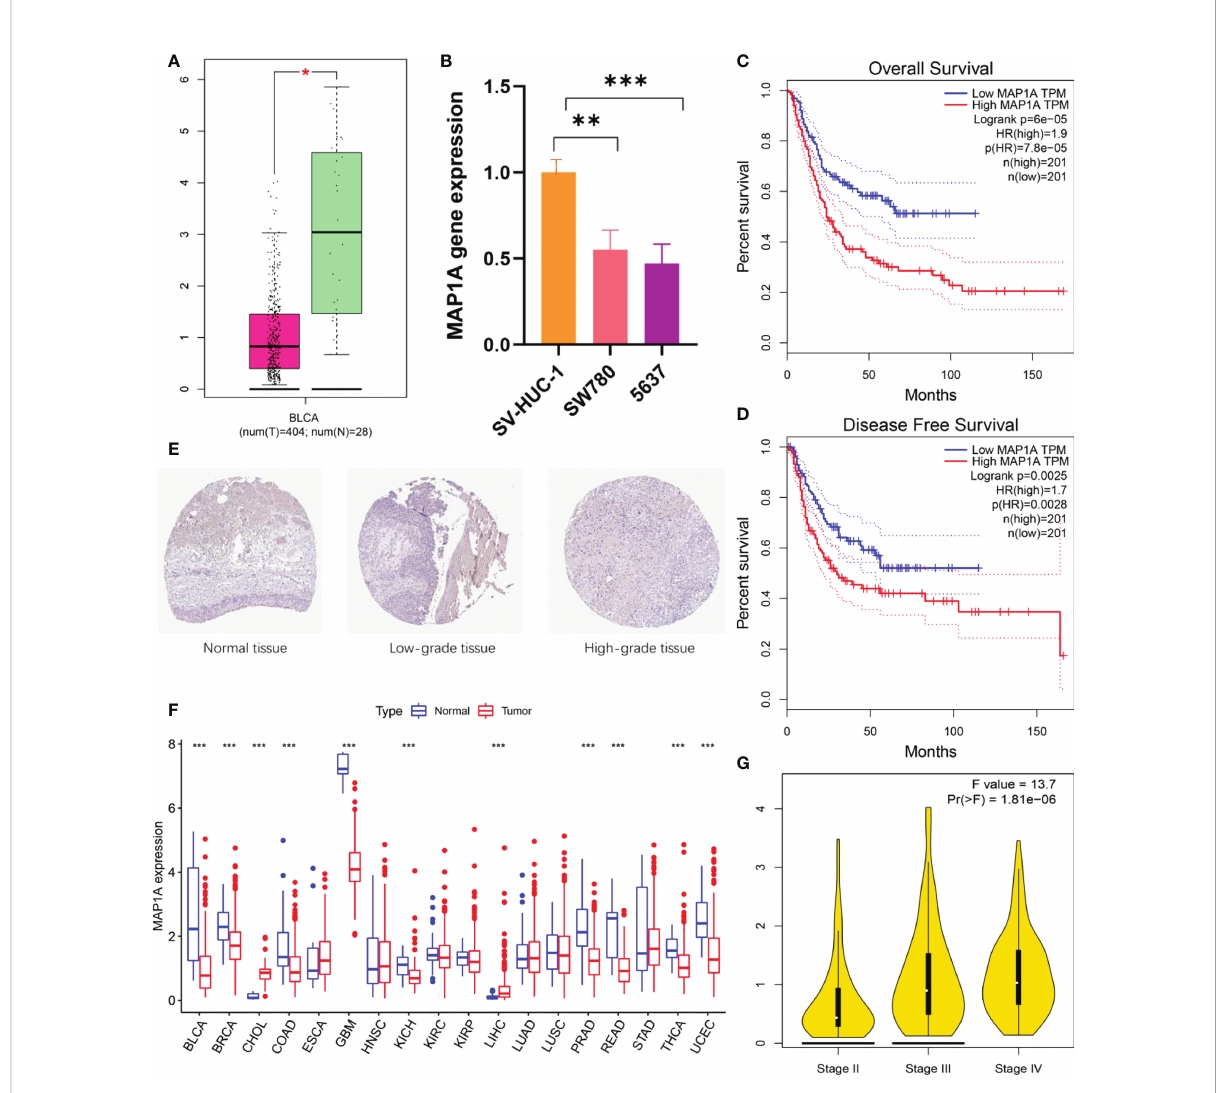
FIGURE 4 MAP1A gene expression and prognosis validation. (A) Validation of MAP1A expression in bladder cancer tissue samples and normal tissue samples using the GEPIA database and the GETx database. (B) MAP1A expression in bladder cancer cells SW780 and 5637, as well as normal bladder epithelial cells SV-HUC-1. (C) MAP1A in the GEPIA database for overall survival analysis of bladder cancer. (D) MAP1A correlation with disease-free survival in bladder cancer (GEPIA database). (E) MAP1A expression in bladder cancer tissues (immunohistochemistry, HPA database). (F) MAP1A expression in pan-cancer. (* indicates P < 0.05, ** indicates P < 0.01, *** indicates P < 0.001). BRCA, Breast invasive carcinoma; CHOL, Cholangiocarcinoma; COAD, Colon adenocarcinoma; ESCA, Esophageal carcinoma; GBM, Glioblastoma multiforme; HNSC, Head and neck cancer; KIRC, Kidney renal clear cell carcinoma; KIRP, Kidney renal papillary cell carcinoma; LIHC, Liver hepatocellular carcinoma; LUAD, Lung adenocarcinoma; LUSC, Lung squamous cell carcinoma; PRAD: Prostate adenocarcinoma; READ, Rectum adenocarcinoma; STAD, Stomach adenocarcinoma; THCA, Thyroid carcinoma; UCEC, Uterine corpus endometrial carcinoma. (G) The expression of MAP1A in different stage of bladder